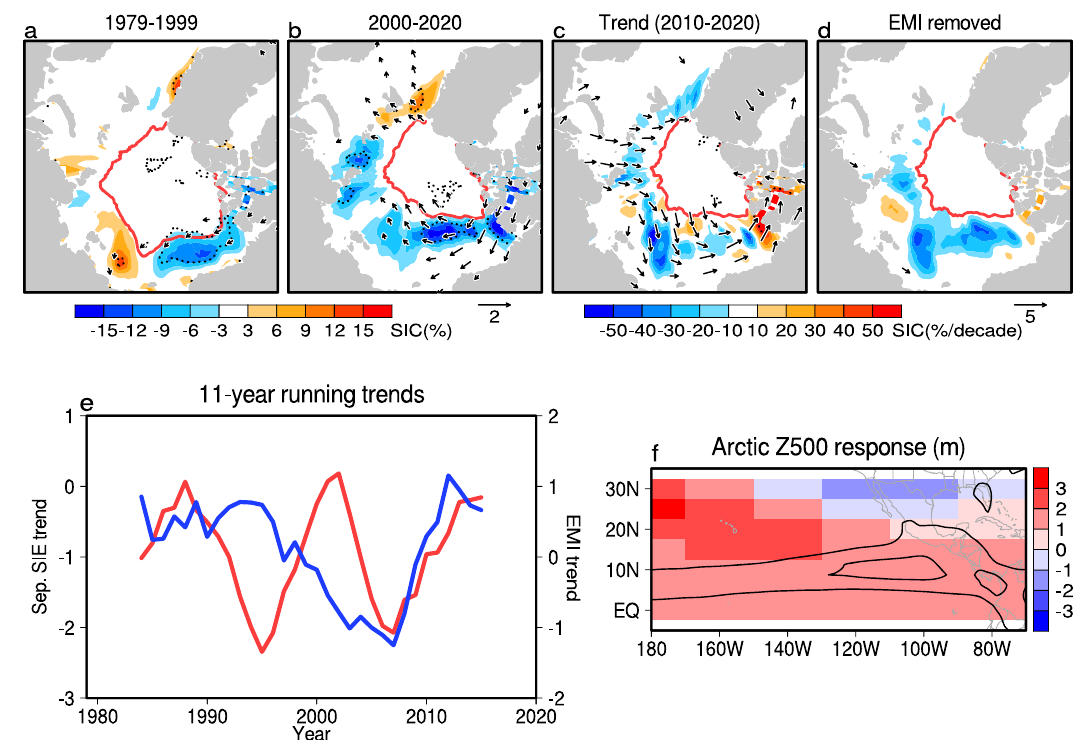
Fig. 5 Relation between recent slowdown in Arctic sea-ice loss and central Paci fi c ENSO. Regressed anomalies of detrended summertime sea-ice concentration (SIC) (shaded; %) and 10-m wind (vectors; m s − 1 ) onto EMI for ( a ) 1979 – 1999 and ( b ) 2000 – 2020. c As in ( a ) and ( b ), but for linear trends for 2010 – 2020. d As in ( c ), but for after removing the EMI-related component. The polarity of EMI is reversed to focus on Arctic sea-ice loss. Dotted contours indicate the 95% signi fi cant level, and red contours indicate mean SIC of 90%. ( e ) Running 11-year trends of EMI (red line) and September SIE (blue line; Million km 2 /11-year). f As in Fig. 4c, but for Arctic response (70° – 90°N, 180° –